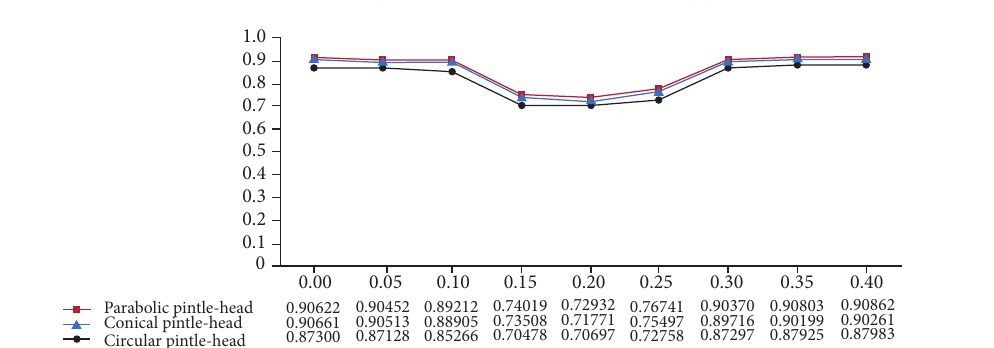
Figure 6. Total pressure recovery coefficient values of pintle